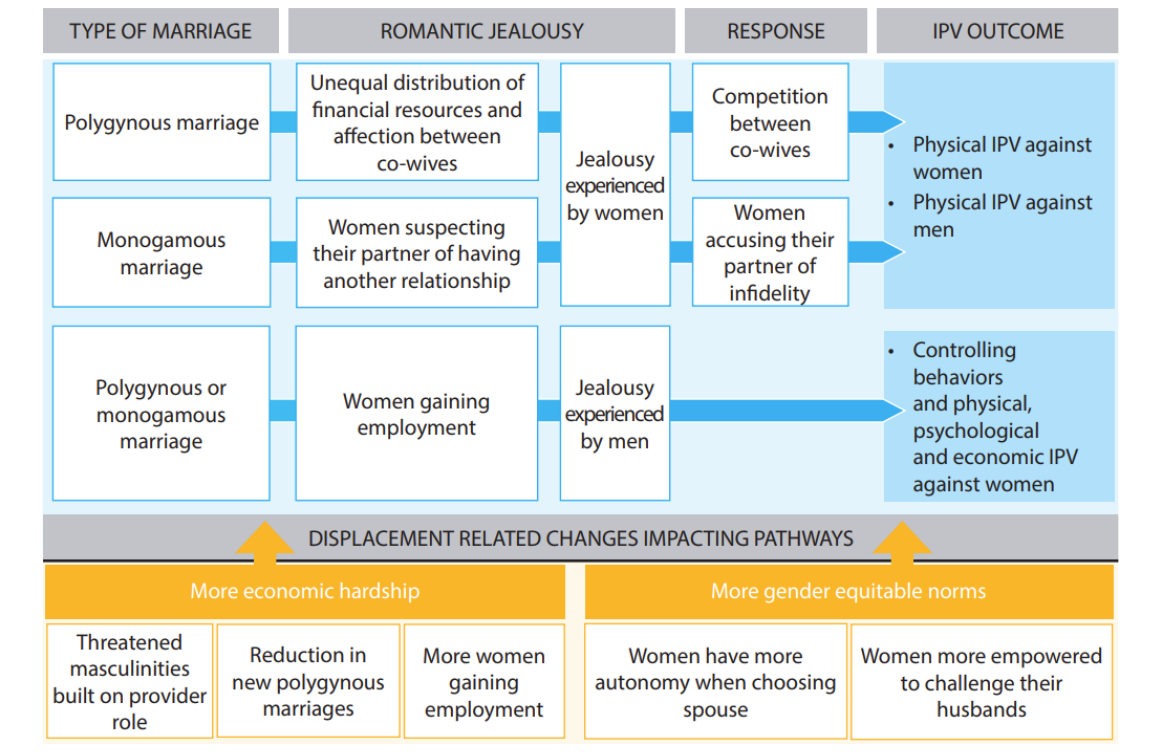
Figure 1. Identified pathways from romantic jealousy to intimate partner violence (IPV) against women and men in polygynous and monogamous relationships.